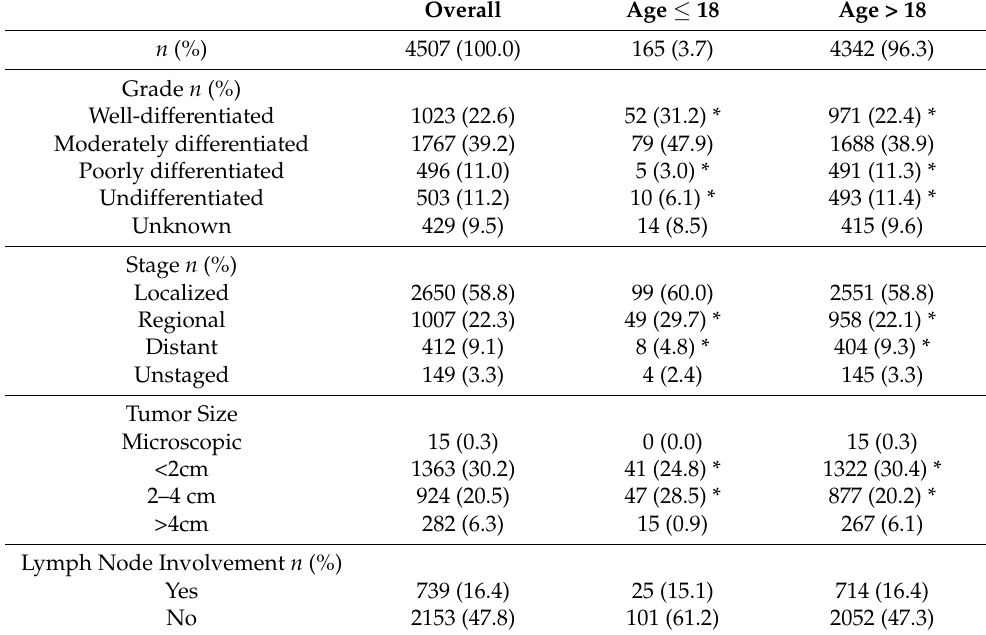
Table 2. Tumor Characteristics and lymph node involvement of 4507 Patients with Mucoepidermoid Carcinoma (MEC) from the Surveillance Epidemiology and End Result (SEER) Database (2000–2018). Tumor grade, tumor stage, tumor size, and lymph node involvement are compared between pediatric and adult groups. Chi-Square test analysis was performed to determine significant differences between age groups. Overall Age ≤ 18 Age > 18